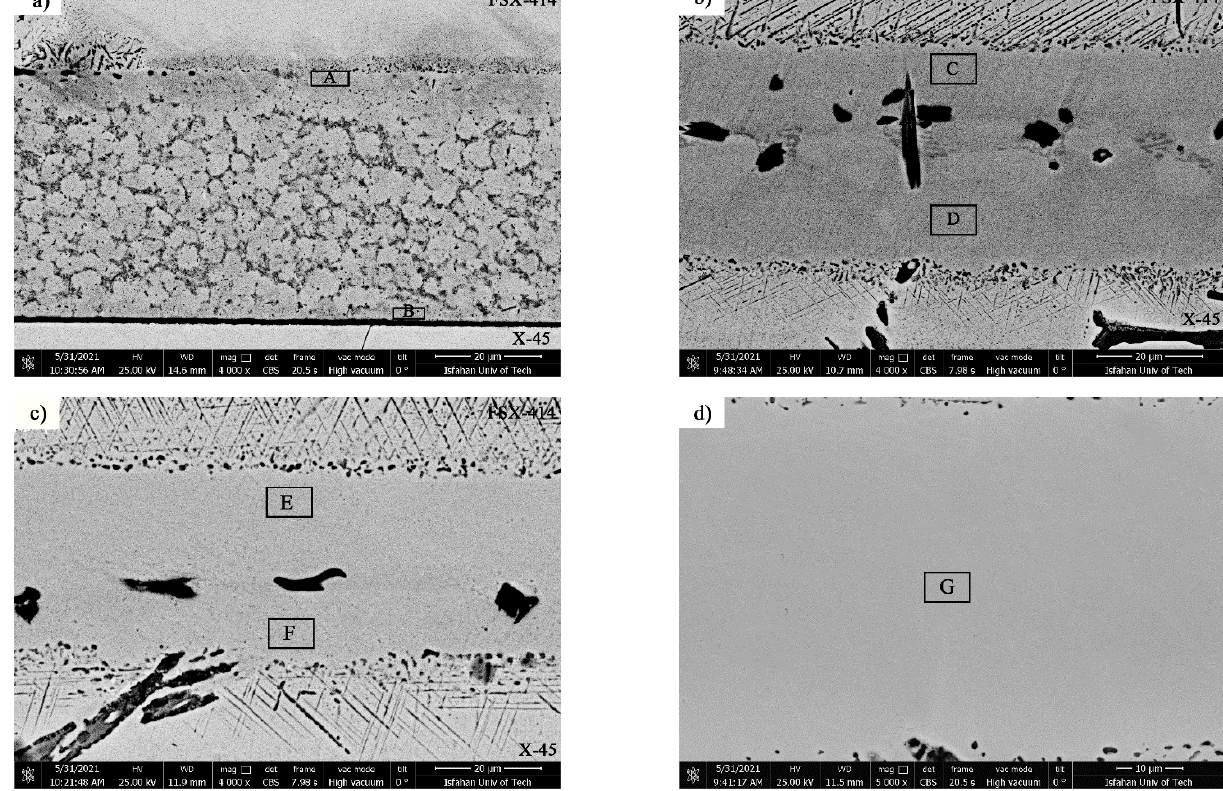
Figure 13. SEM microstructural revolutions of the bonding zones at a constant holding time of 10 min and different temperatures: ( a ) 1010 ◦ C (A = ISZ FSX-414 and B = ISZ X-45 ), ( b ) 1050 ◦ C (C = ISZ FSX-414 and D = ISZ X-45 , ( c ) 1100 ◦ C (E = ISZ FSX-414 and F = ISZ X-45) , and ( d ) 1150 ◦ C (G = ISZ). Table 4. EDX analysis of various phases indicated in Figure 13 (wt. %). Zones